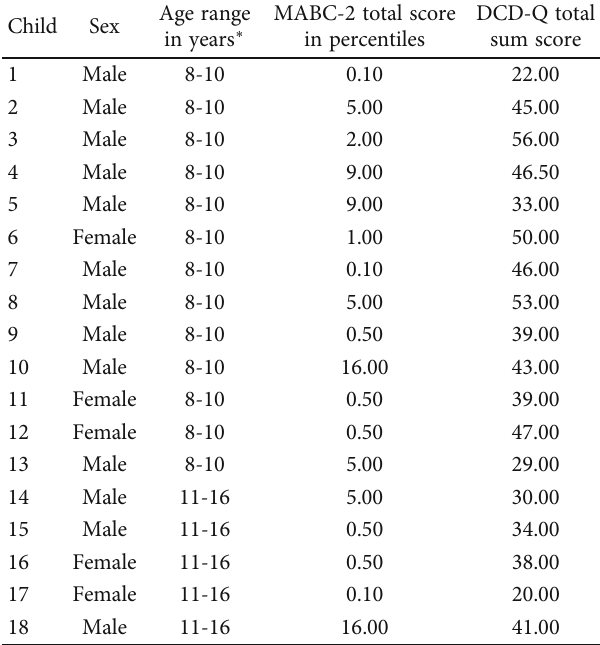
Table 1: Detailed participant